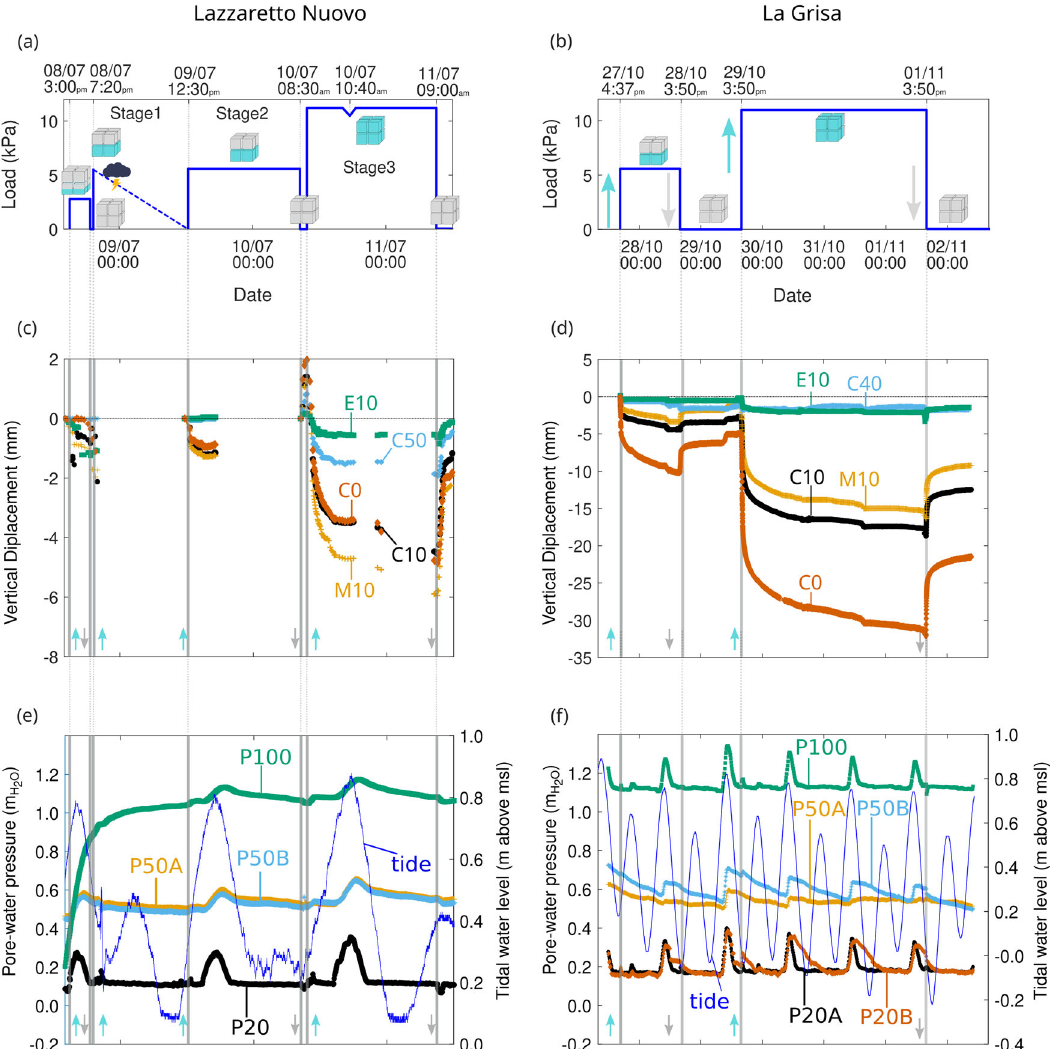
Fig. 3 Datasets collected during the loading experiments at Lazzaretto Nuovo (NL, left panels) and La Grisa (LG, right panels) in the Venice Lagoon. a , b Load applied on the marsh surface following the various loading and unloading phases with the fi lling and emptying of the tanks. The fi lling and emptying last approximately 30 – 45 min. The loading experiments lasted from July 8 to July 11 in 2019 at LN and from October 27 to November 2 in 2020 at LG. c , d Vertical displacement registered by each sensor versus time measured during loading and unloading phases. Negative values mean settlement, positive values mean uplift. C0, C10 and C50 (C40 in LG) are located directly below the load center and refer to the marsh surface, and 0.1 and 0.5 m (0.5 m) depth. E10 and M10 refer to a 0.1 m depth at the edge of the loaded area and in an intermediate position respectively (see also Fig. 1a). e , f Pore- water pressure (left axis) and tidal water level (right axis) measured during the loading and unloading phases at various depths. P20, P50, and P100 refer to deployment depth equal to 0.2, 0.5 and 1.0 m below the marsh surface. Letters A and B identify sensors located on the two sides of the experiment, as indicated in Fig.